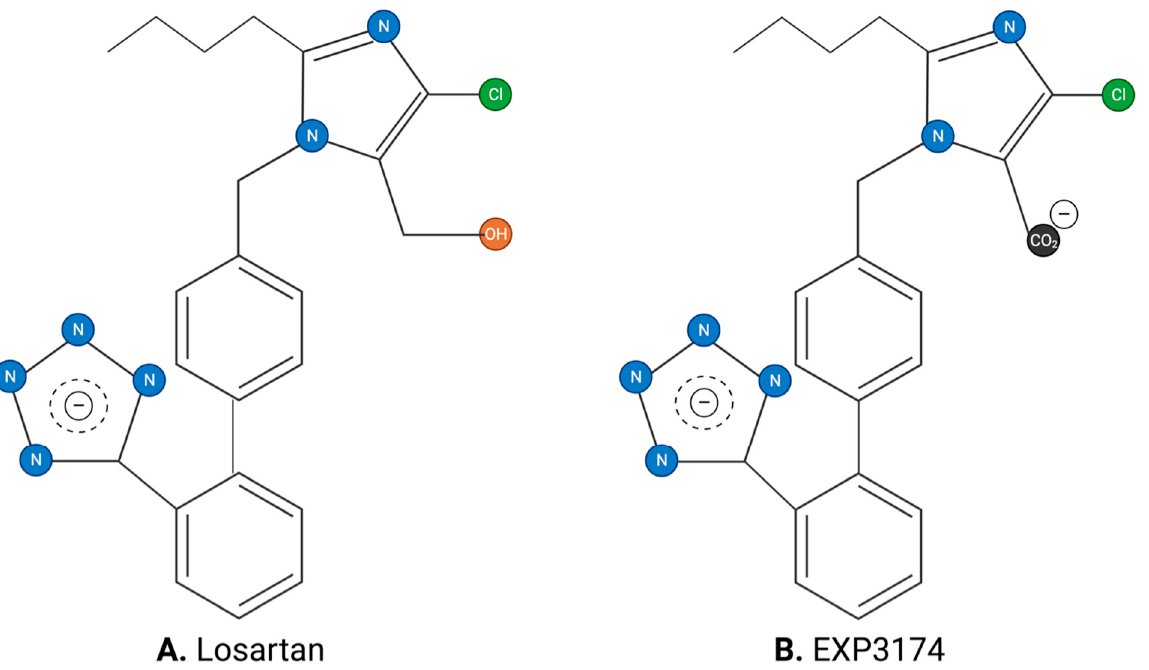
Figure 3. Angiotensin receptor blockers: (A) losartan (surmountable) and (B) EXP3174 (insur- mountable).